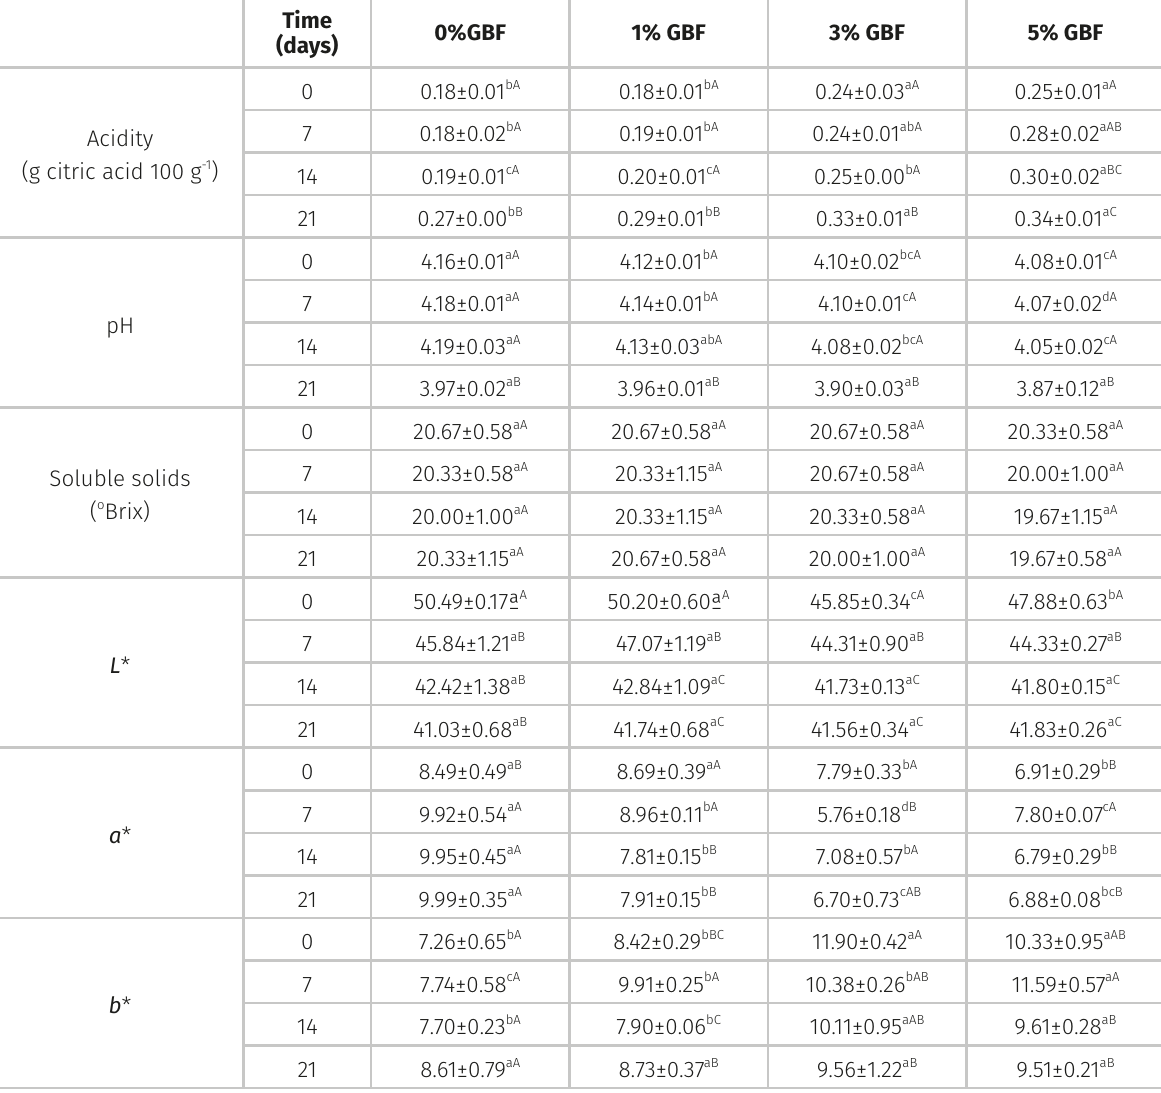
Table I. Acidity, pH, soluble solids and color parameters (L*. a*. b*) of guava juice formulations containing 0. 1. 3 and 5% of guava by-product (GBF) at 0, 7, 14 and 21 days of storage at 4